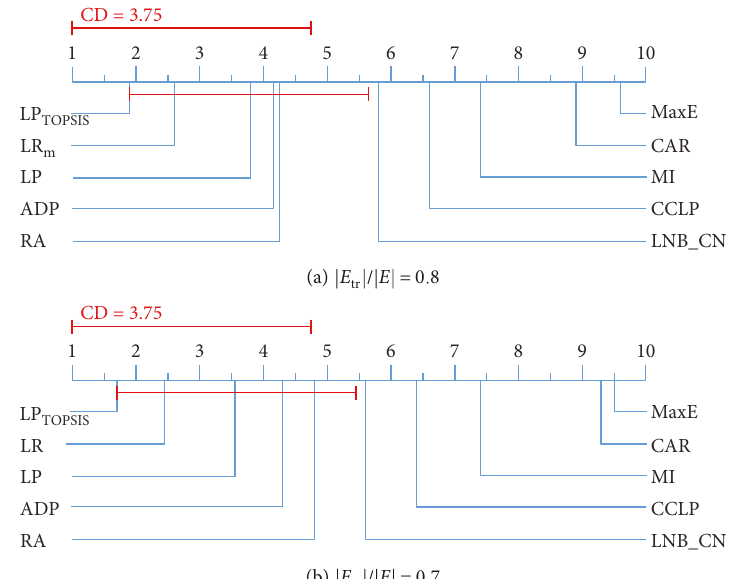
Figure 6: The Bonferroni-Dunn test for E from LP TOPSIS